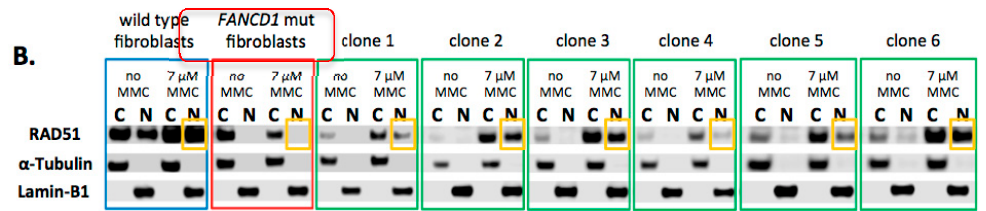
Figure 4. FANCD1 functional assessment. ( A ) Cellular viability assay. Triplicate samples of gene corrected clones were assessed for viability in response to the PARP inhibitors olaparib or KU0058948. Tetrazolium dye reduction was assessed at 490 nm over four concentrations. Controls were wild type or FANCD1 null fibroblasts of equivalent passage number; ( B ) RAD51 nuclear translocation. Cytoplasmic (“C”) or nuclear (“N”) fractions of untreated or MMC treated cells were analyzed by Western blot for RAD51 localization. Loading controls were α -tubulin or lamin-b1 [28] for the cytoplasmic or nuclear fractions, respectively. Blots are representative of at least two experiments on each of the indicated clones.